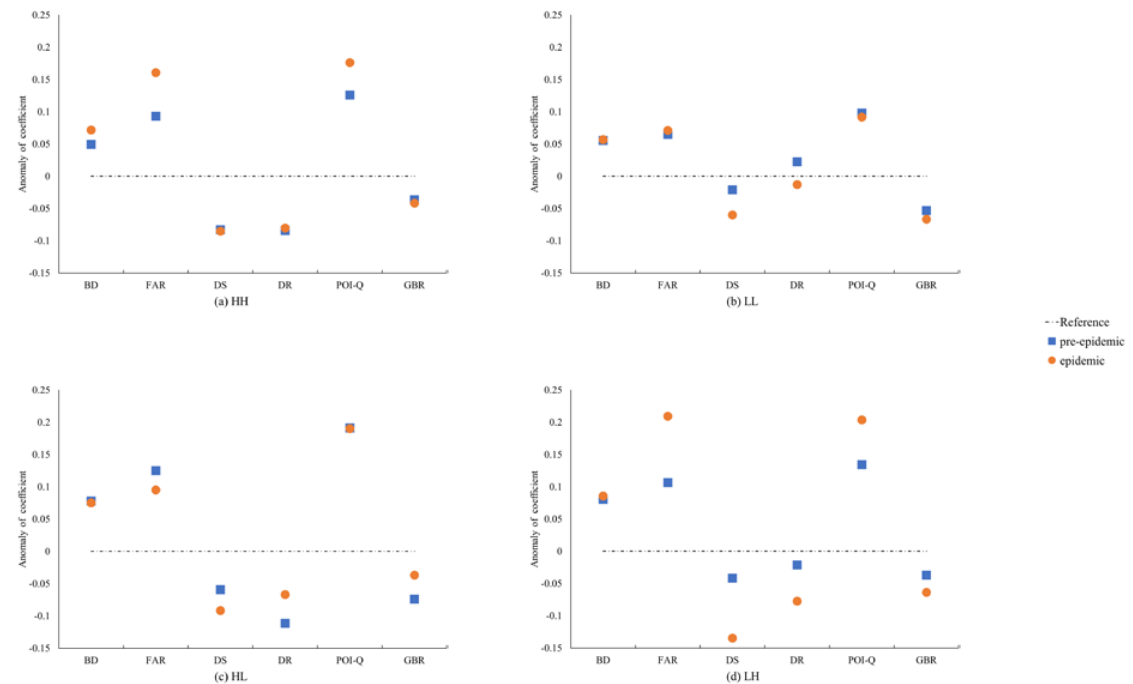
Figure 6. Anomalies of factors’ coefficient during the pre-epidemic and epidemic periods. ( a ) HH type; ( b ) LL type; ( c ) HL type; ( d ) LH type